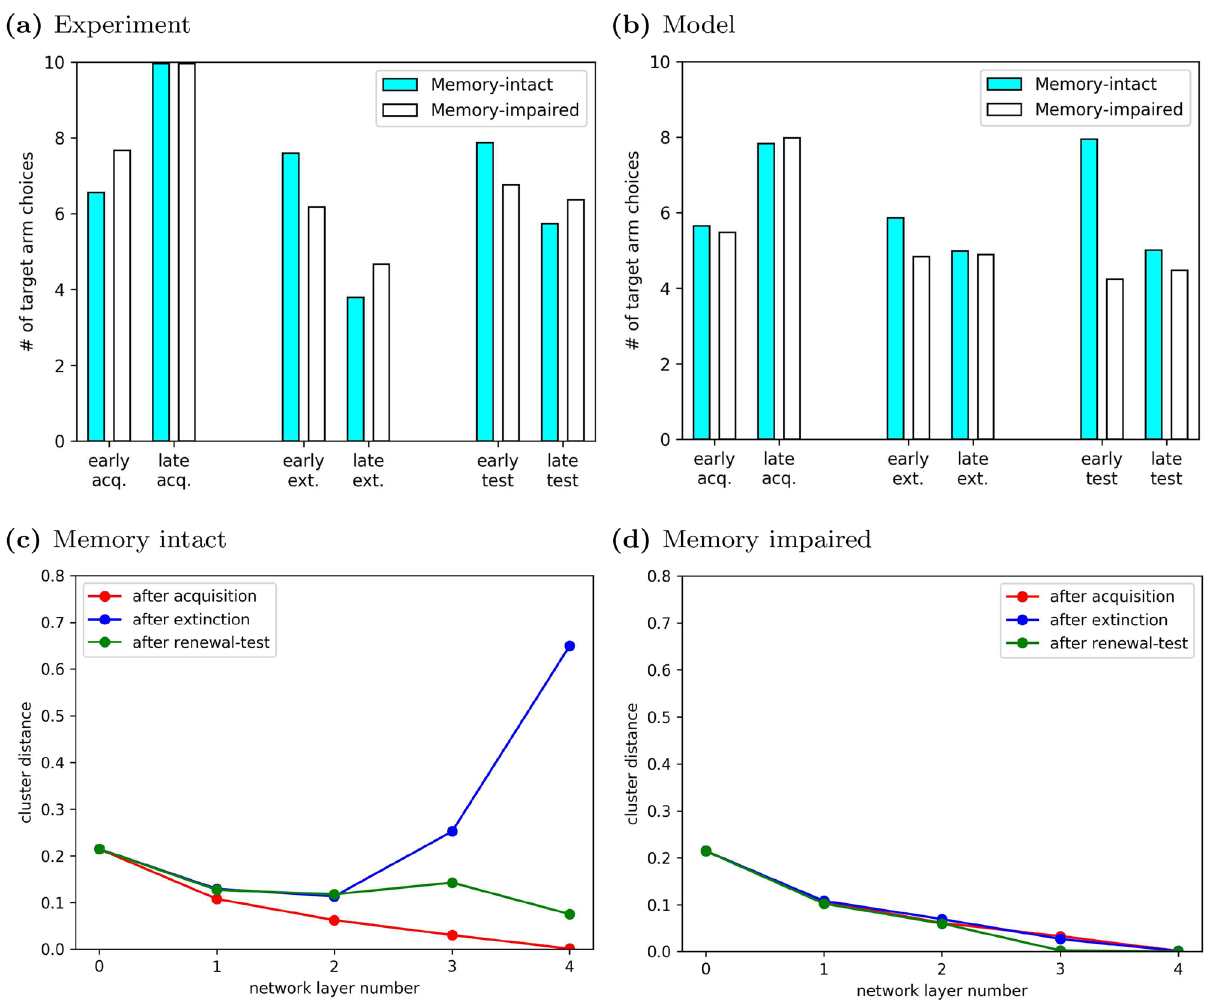
Figure 7. ABA renewal arises because experience replay drives the emergence of two distinct context representations. ( a ) André and Manahan-Vaughan showed that renewal was reduced by a pharmacological manipulation that interfered with synaptic plasticity in the hippocampus. (Adapted from Fig. 1 in Ref. 9 .) R ≈ 0.45 R ≈ 1.08 Renewal score in experimental animals: S , renewal score in control animals: S . ( b ) In our model, agents with intact experience replay memory showed ABA renewal in the T-Maze task, i.e. an increase in R ≈ 0.59 response rate in early test despite the continued absence of reward ( S ). By contrast, memory-impaired R ≈ − 0.14 agents did not exhibit renewal and had a lower renewal score ( S ). ( c ) Cluster distances between network representations of context A and B in the T-maze for memory-intact agents. Results were averaged over 1000 runs of our model. The representation of contexts A and B in higher layers of the deep neural network ( l ≥ 3 ) formed distinct clusters that were well separated. They were learned in the extinction phase, since the distinction was not present at the end of the acquisition phase. ( d ) By contrast, memory-impaired agents did not show distinct context representations in any learning